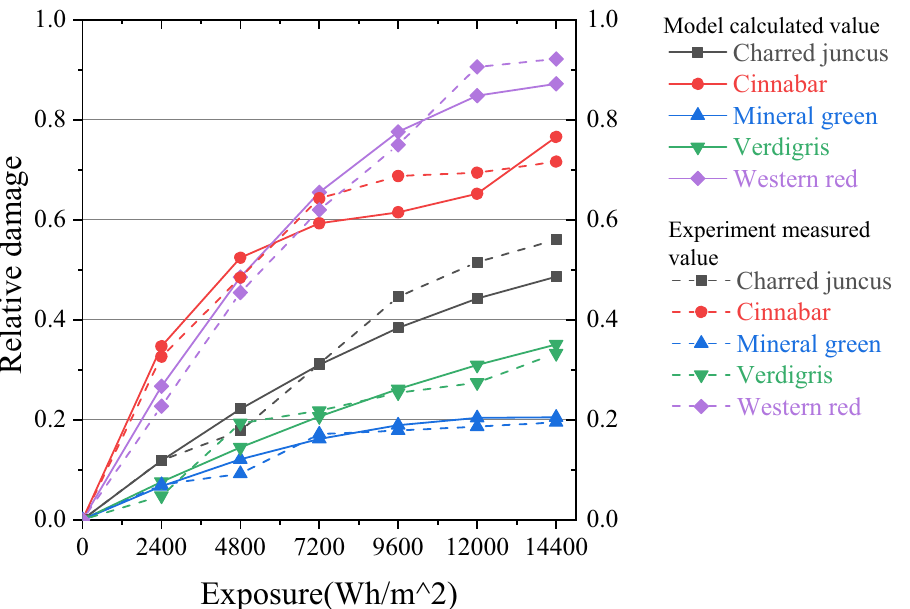
Figure 6. Comparison of experiment measured value and model calculated value.